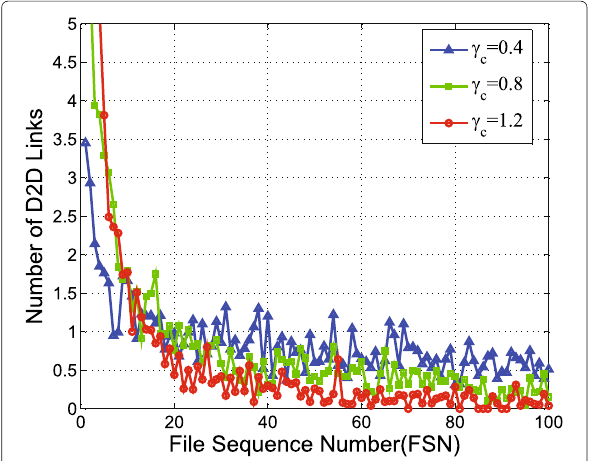
Fig. 5 The average number of D2D links with different ordinate scale. This figure shows the number of D2D links established with different ordinate